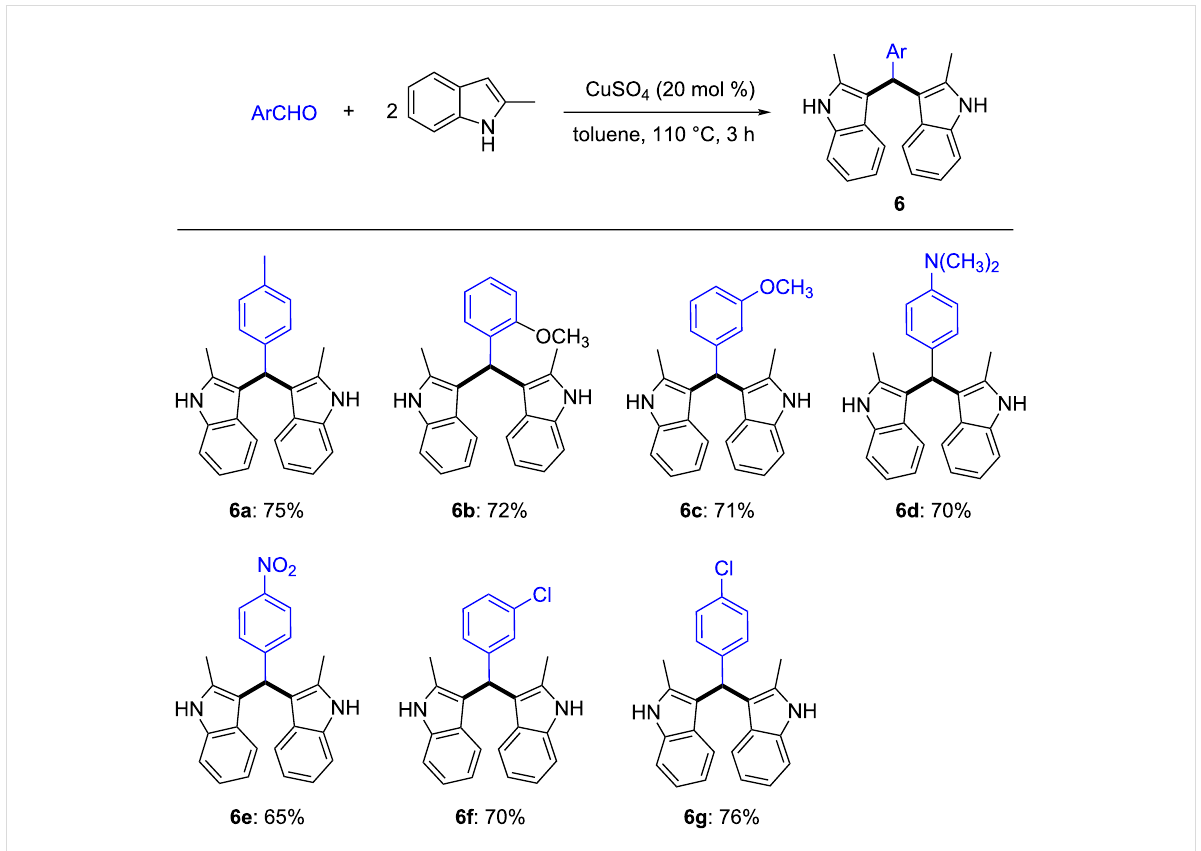
Scheme 6: Synthesis of 3,3'-(arylmethylene)bis(2-methyl-1 H -indole). Reaction conditions: 2-methylindole (1.0 mmol), aromatic aldehyde (0.5 mmol),